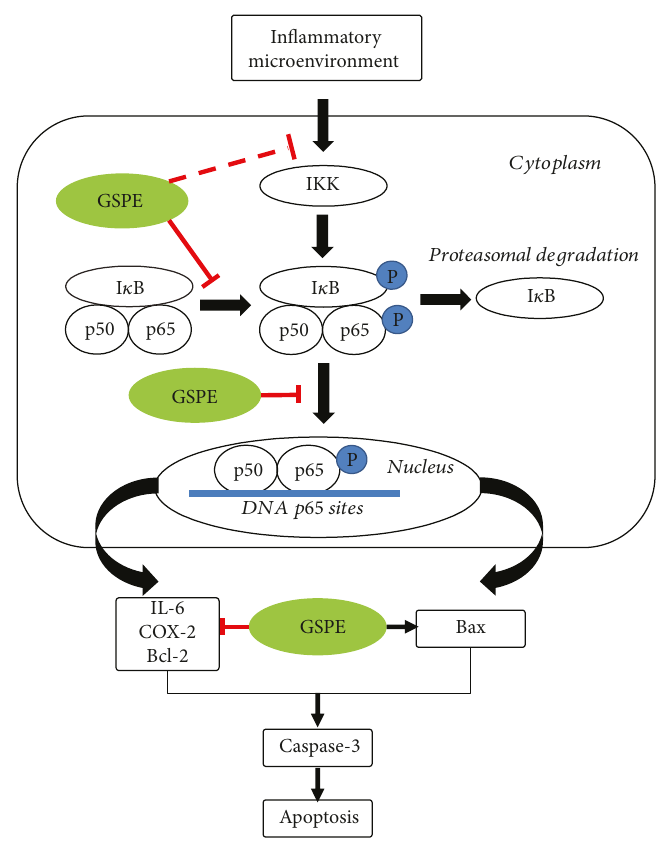
Figure 10: GSPE induced apoptosis in ECA109 cells via NF- κ B